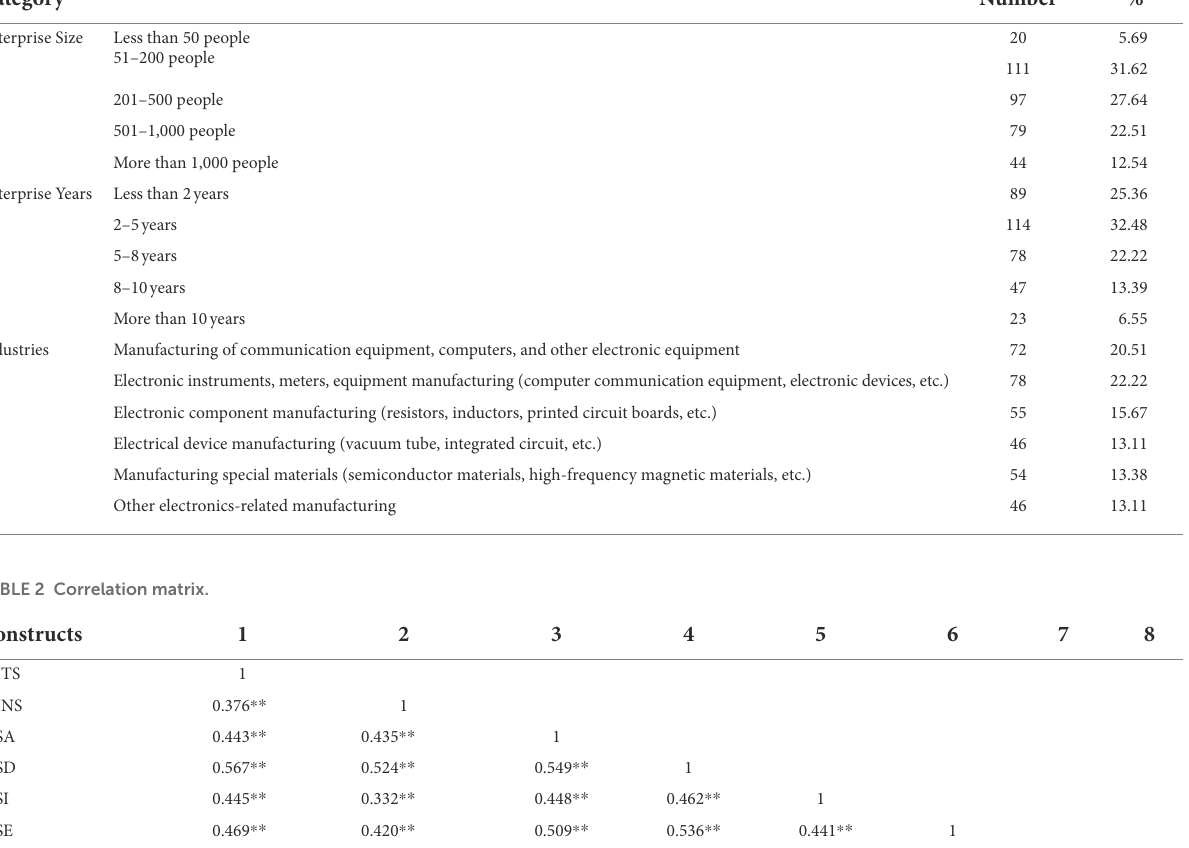
TABLE 1 Sample characteristics ( N = 351).